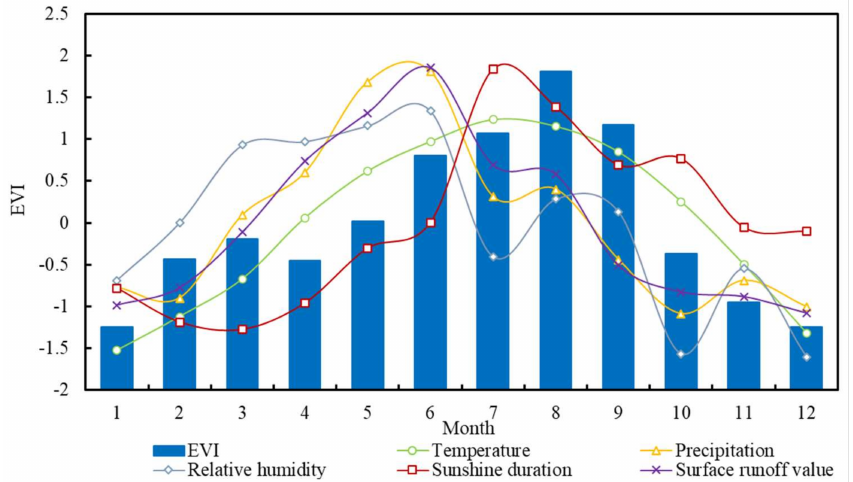
Figure 6. Multi-year monthly mean EVI, temperature, precipitation, relative humidity, sunshine duration, and surface runoff depth during